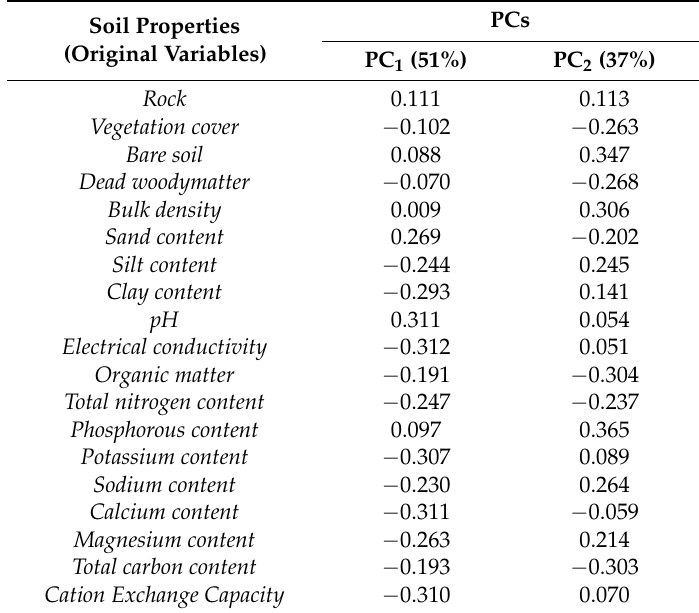
Table 4. Factor loadings on the first three principal components (PC) applied to properties of soils subjected to different land uses in the study area (Villamalea, Castilla La Mancha, SE